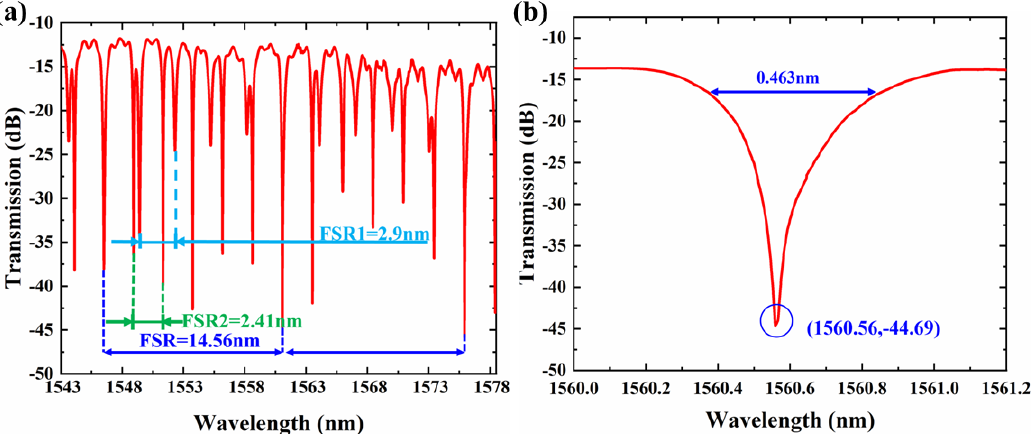
Figure 2. ( a ) The spectrum of the dual-MRR sensor. ( b ) The transmission of overlapping resonant peaks.